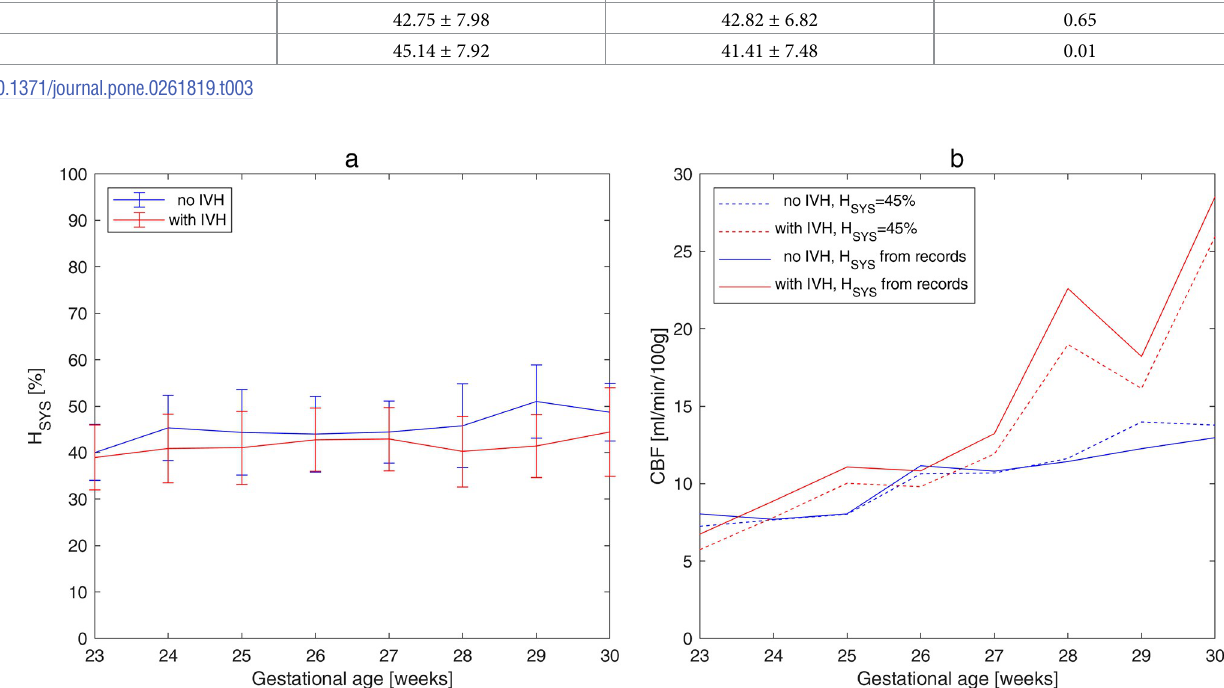
Fig 4. Mean values with standard deviations averaged over gestational age. (a) Measured systemic hematocrit. (b) CBF calculated for H SYS = 45% (dashed lines) and for H from clinical records (solid SYS